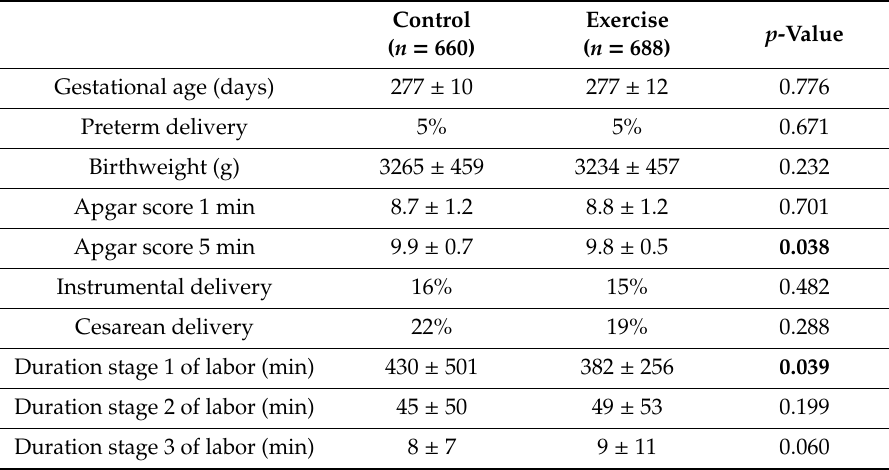
Table 2. Delivery endpoints by